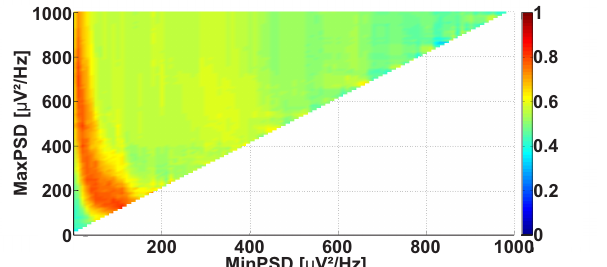
Figure 8. An example of the Power spectral density AUC diagram. The abscissa axis is the lower bound of the PSD range; the ordinate axis is the upper bound of the PSD range. A bright red region is observed along the ordinate axis above 70 µ V 2 /